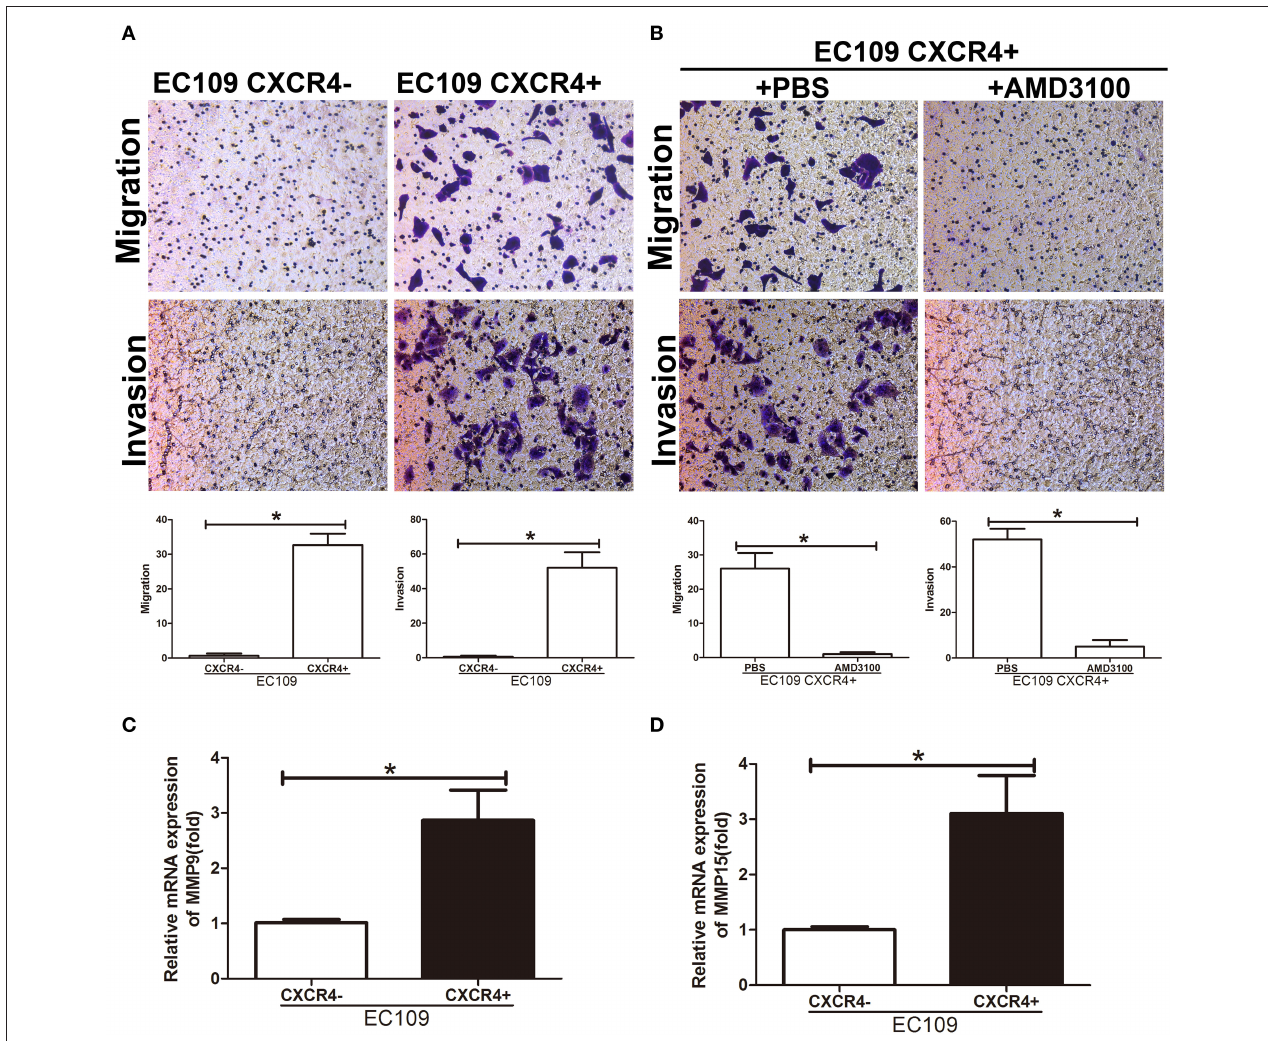
FIGURE 4 | CXCR4 promoted cell migration and invasion. (A,B) Migration and invasion assays were performed using Transwell chambers. (C) The expression analysis of MMP9 was detected by real time PCR. (D) The expression analysis of MMP15 was detected by real time PCR. * P <